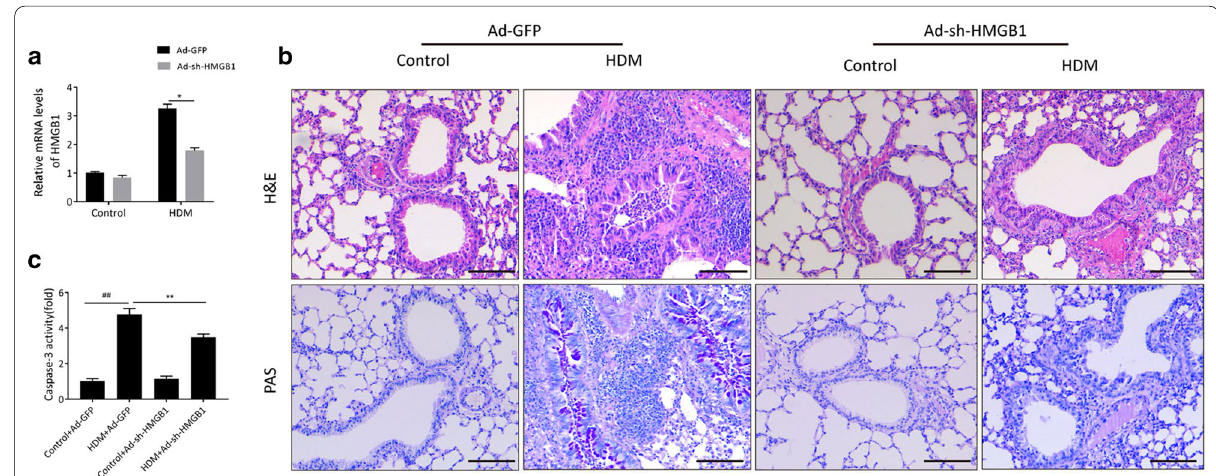
Fig. 5 HMGB1 deficiency alleviates airway damage in HDM-induced mice. Ad-GFP and Ad-sh-HMGB1 mice were generated by intratracheally delivery of recombinant adenovirus, and then subjected to saline (negative control) or HDM exposure. a Relative mRNA levels of HMGB1 in mouse lungs. b Histopathological analysis of lung tissue sections by H&E or PAS staining. c The caspase-3 activities of the lungs in different treatment groups. Data are expressed as ## p < 0.05 vs. control Ad-GFP group; *p < 0.05 vs. HDM Ad-GFP group; **p < 0.01 vs. HDM Ad-GFP + + +